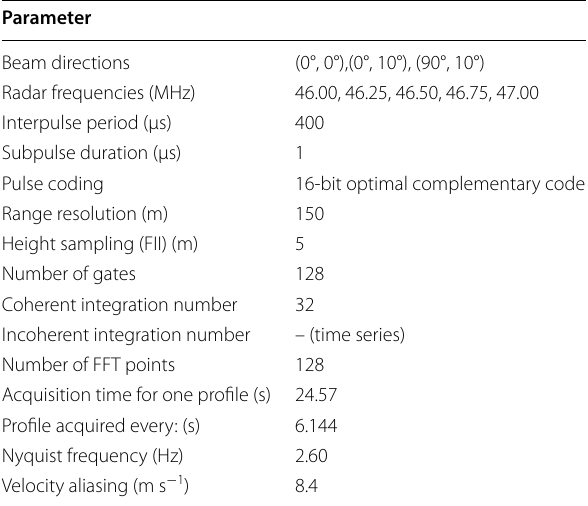
Table 1 MU radar parameters used during ShUREX